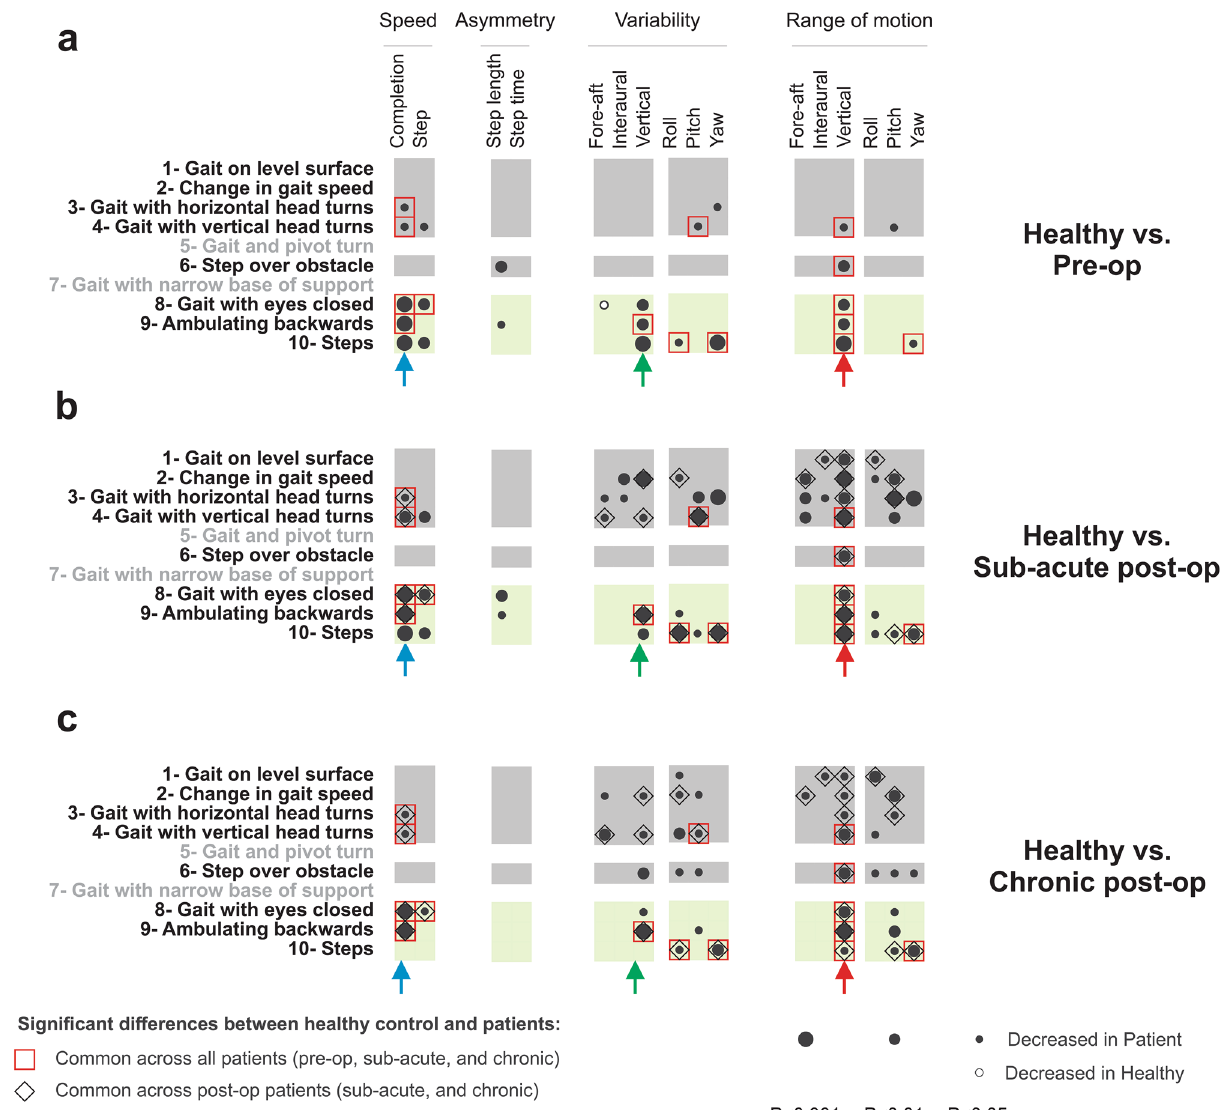
Figure 3. Comparison of objective head movement kinematics between ( a ) pre-op ( b ) sub-acute post-op ( c ) chronic post-op patients and healthy controls during FGA tasks (1–4,6,8–10). ( a – c ) Each row corresponds to one of the FGA tasks, while columns correspond to kinematic measures that are associated with one of four main categories; (1) speed, (2) asymmetry, (3) variability, and (4) range of motion. The circles demonstrate the kinematic measures in each task that distinguish patients from healthy controls. Dark circles show decreased measure in patients, while the white circle means that measure was decreased in the healthy group. The radius of the circle indicates the level of significance of the difference between the two groups. Open red squares denote the differences with the healthy subjects that are common in patients across all time points. Open black diamonds show the differences that are common only across two post-op time points. Blue, green, and red arrows highlight specific kinematic measures that were most informative across all FGA (compare Fig. 3a,b), even including some of the less challenging tasks (grey shaded rows). Finally, similar to pre-op patients, sub-acute post-op patients took longer to complete the majority (5/8) of tasks ( p < 0.05, denoted by the blue arrow) 6 weeks after surgery. Finally, when we tested the same VS patients in the chronic post-op state (Fig. 3c), we found that many of the changes observed relative to healthy controls 6 weeks following surgery persisted > 6 months after surgery (common changes denoted by open black diamonds in Fig. 3b,c). Specifically, the range of vertical head accel- erations remained reduced relative to healthy controls across all tasks (Fig. 3c; red arrow). Likewise, patients showed decreased variability of vertical head acceleration across (5/8) tasks (green arrow), and also took longer to complete many (4/8) tasks (blue arrow) 6 weeks after surgery (sub-acute). Overall, it is noteworthy that 6 months following surgery patients showed fewer significant differences relative to healthy controls than they did 6 weeks following surgery (compare Fig. 3b,c). Furthermore, comparison of patient performance at each